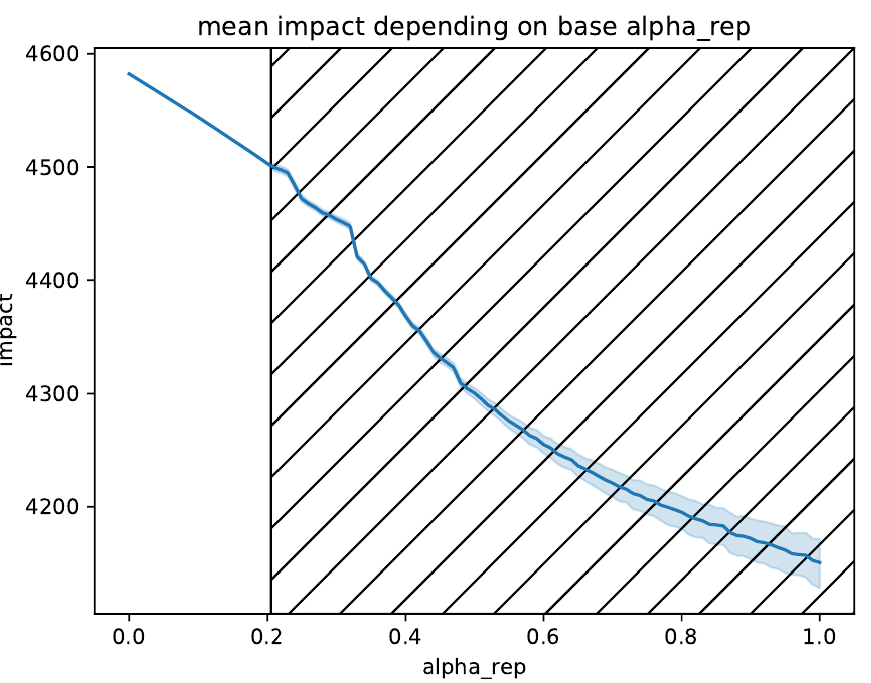
Figure 3. Mean impact versus α rep preset. Hatched area corresponds to rejected α rep values where the policy does not last the whole year.